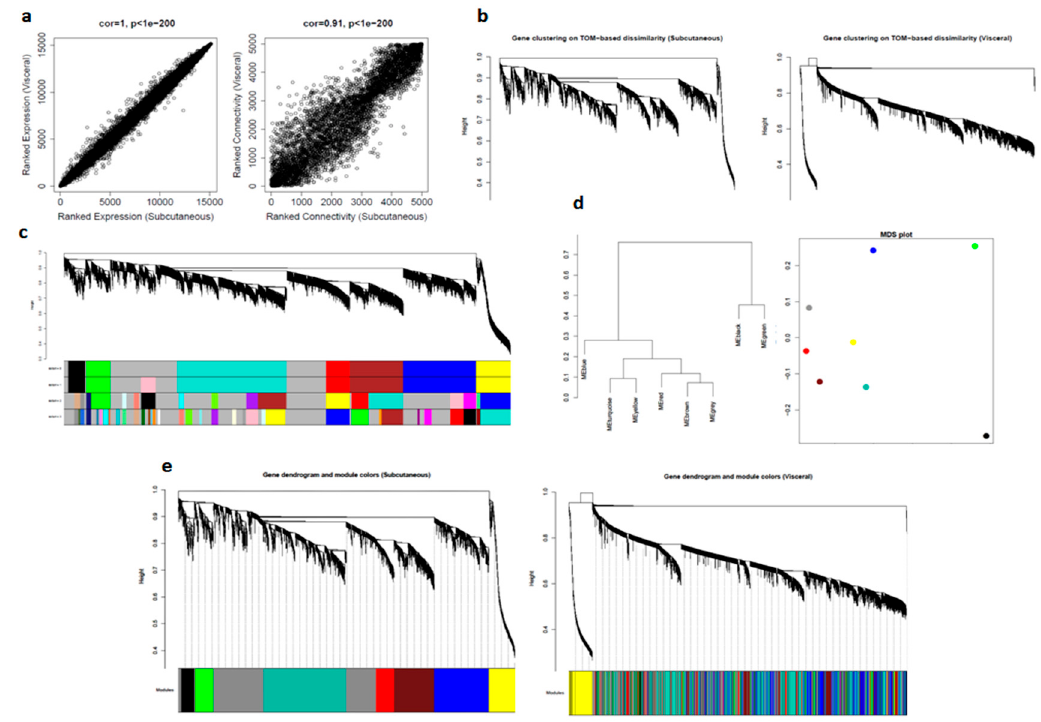
Figure 3. Comparison of visceral and subcutaneous datasets using WGCNA: ( a ) correlation between datasets in average gene expression, and overall connectivity; ( b ) gene dendrograms on TOM-based dissimilarity; ( c ) module choices for deep split values; ( d ) module eigengene visualization; and ( e ) preservation of modules in datasets.